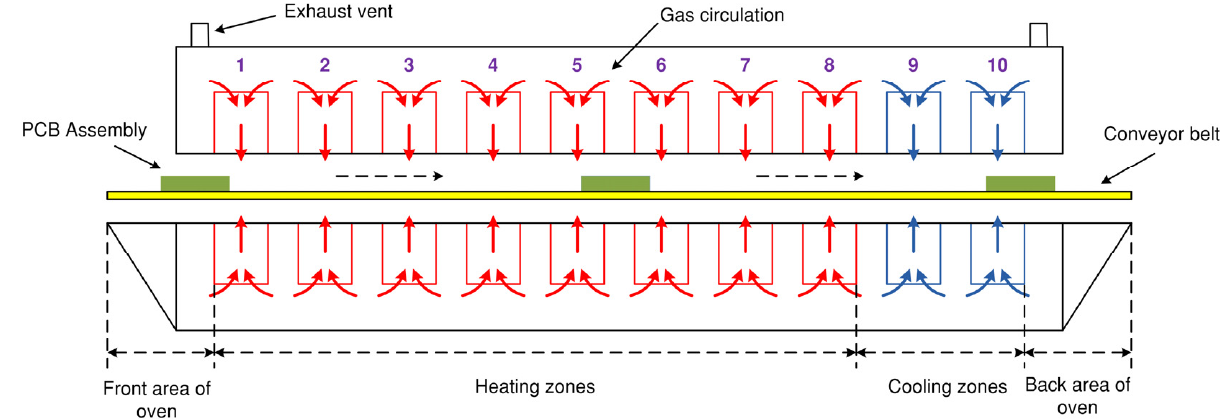
Figure 1. Schematic diagram of the heat transfer during the reflow soldering.